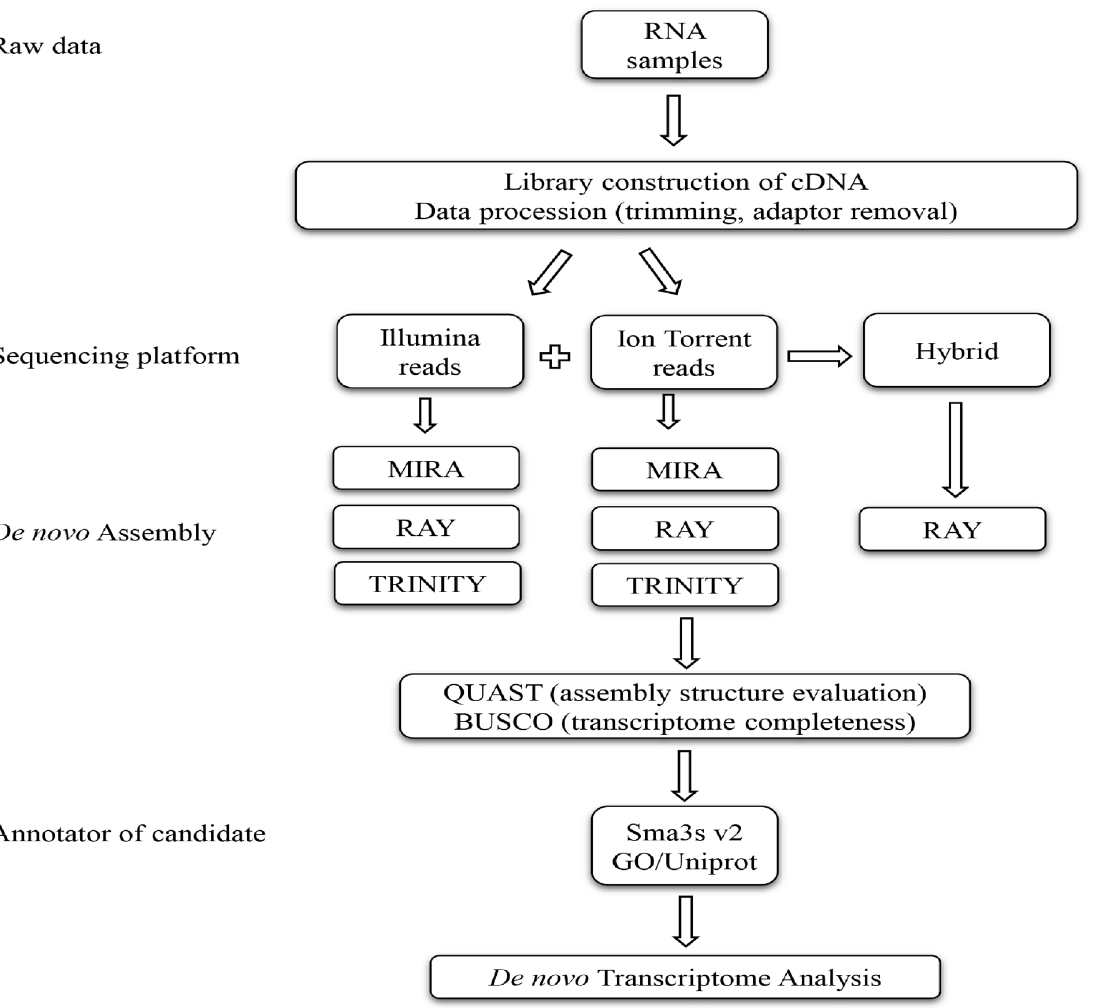
Fig 4. Experimental work flow showing the steps carried out and bioinformatic utilities used for a transcriptome analysis.